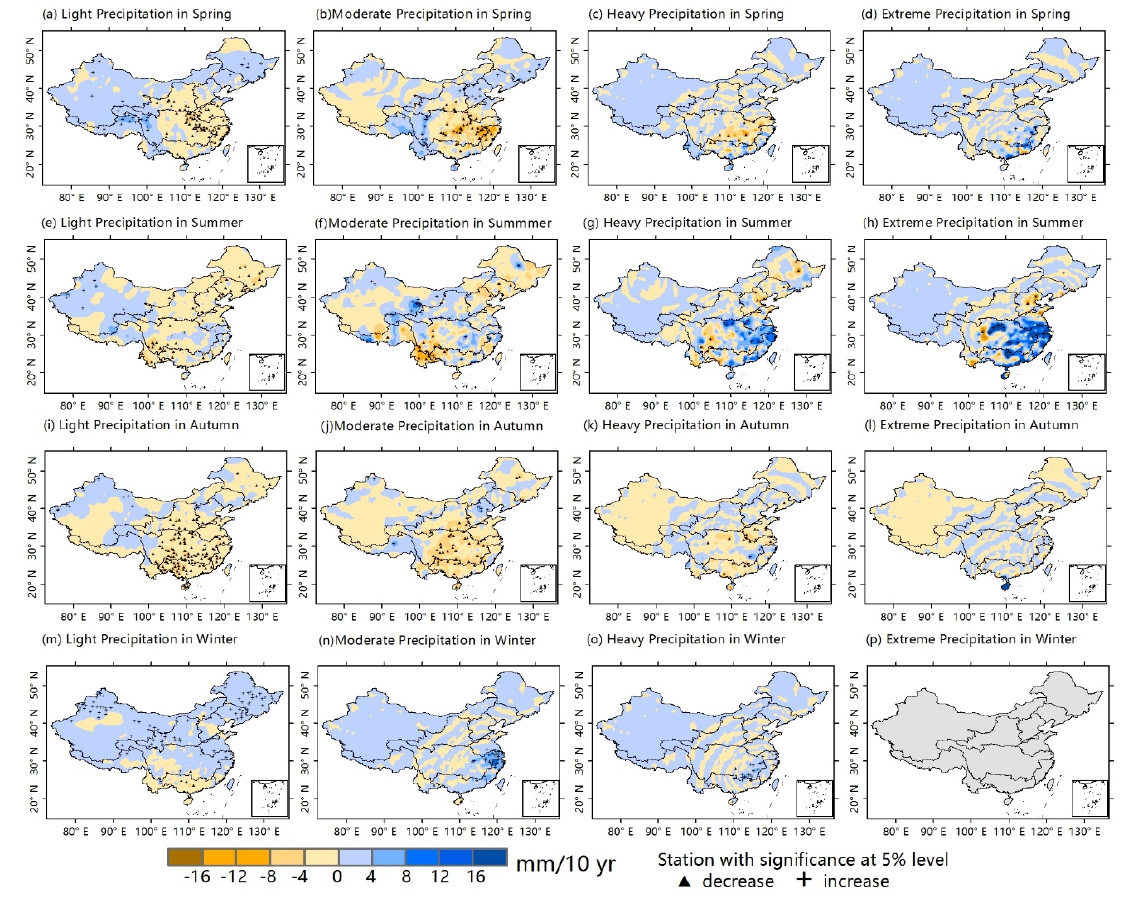
Figure 6. Seasonal trends in precipitation categories during 1960–2013. ( a – d ) Spring; ( e – h ) summer; ( i – l ) autumn; and ( m – p ) winter. For each season, the maps show light, moderate, heavy, and extreme precipitation from left to right.